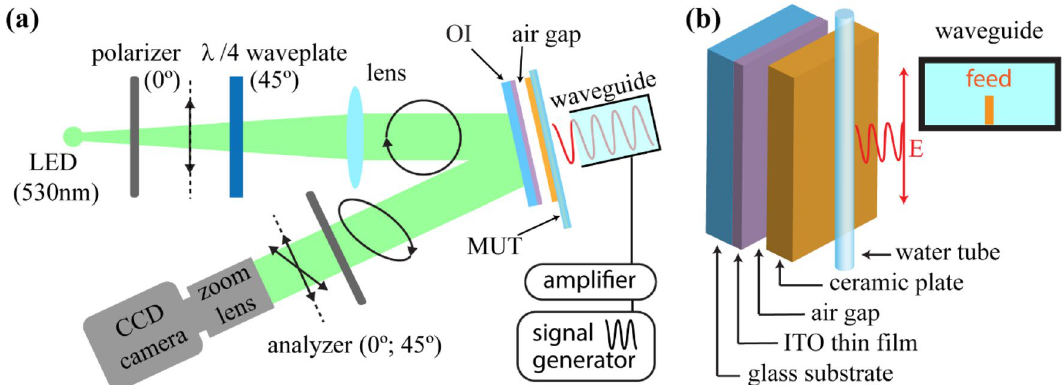
Figure 1. ( a ) Illustration of the visualization system. Probing green light is modulated to be circularly polarized by using a linear polarizer and quarter waveplate. The reflected light passed through the stressed